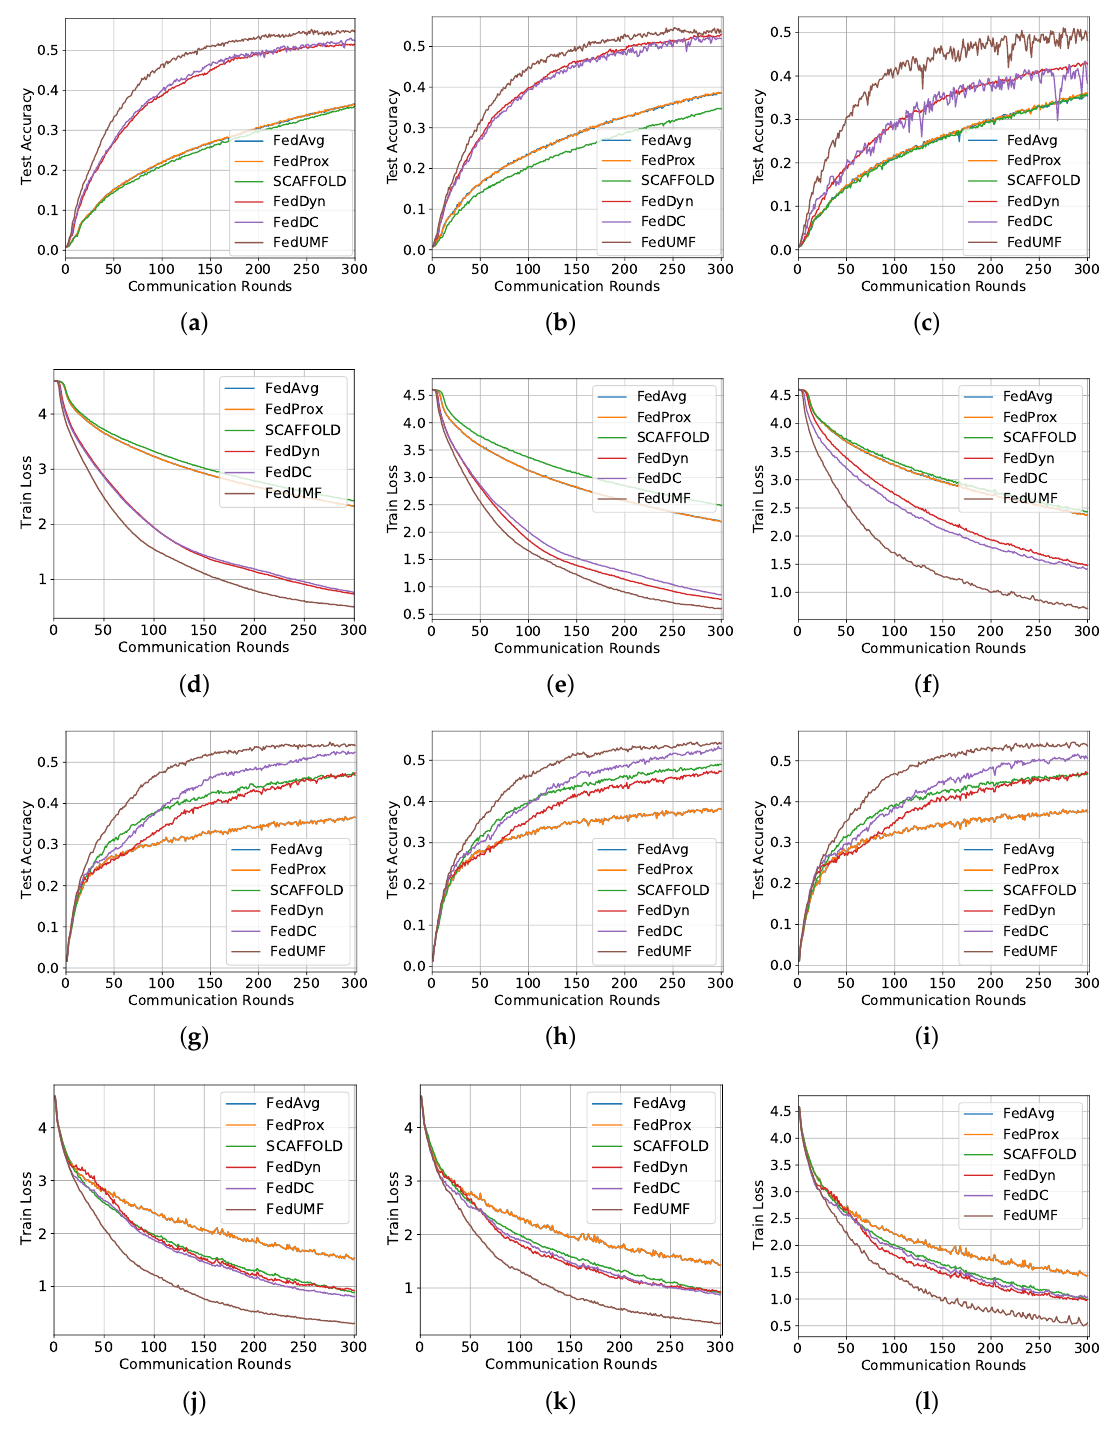
Figure A4. Convergence and loss plots of FedUMF for different setting with 100 clients adopting 15% and 65% client participating settings on CIFAR100. ( a ) Test Acc. IID 15%. ( b ) Test Acc. unbalance 15%. ( c ) Test Acc. Drichlet 0.6 15%. ( d ) Train Loss. IID 15%. ( e ) Train Loss. unbalance 15%. ( f ) Train Loss. Drichlet 0.6 15%. ( g ) Test Acc. IID 65%. ( h ) Test Acc. unbalance 65%. ( i ) Test Acc. Drichlet 0.6 65%. ( j ) Train Loss. IID 65%. ( k ) Train Loss. unbalance 65%. ( l ) Train Loss. Drichlet 0.6